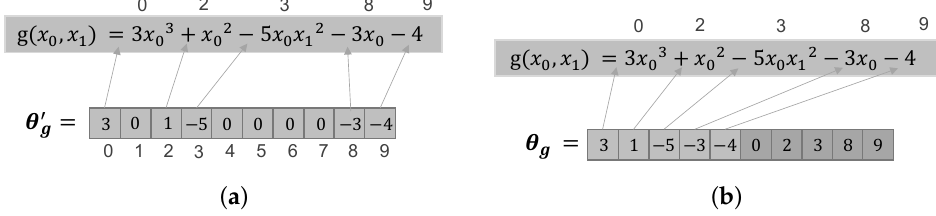
Figure 2. Polynomial representations: Comparison of dense and sparse polynomial representations for an exemplary polynomial. ( a ) Dense polynomial representation: a value at position i represents the coefficient of the i -th monomial in the systematic enumeration. ( b ) Sparse polynomial representation: the polynomial is represented by pairs of the coefficient and index of the monomial in the systematic